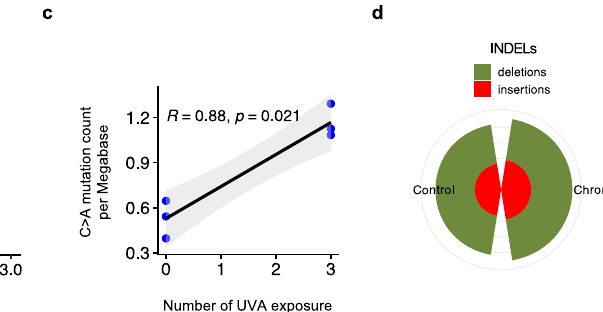
exposures ineach of the 3biologicalreplicates. P -value is calculatedbasedon two- sided t-distribution with n- 2 degrees of freedom. Gray bands represent the 95% con fi dence intervals. d Number of small insertions and deletions (indels) in HEKa cells. Statisticallysigni fi cant results from FDRcorrectedMann – Whitney U tests are denoted as: * q -value < 0.05; ** q -value < 0.01; *** q -value < 0.001; and **** q -value <